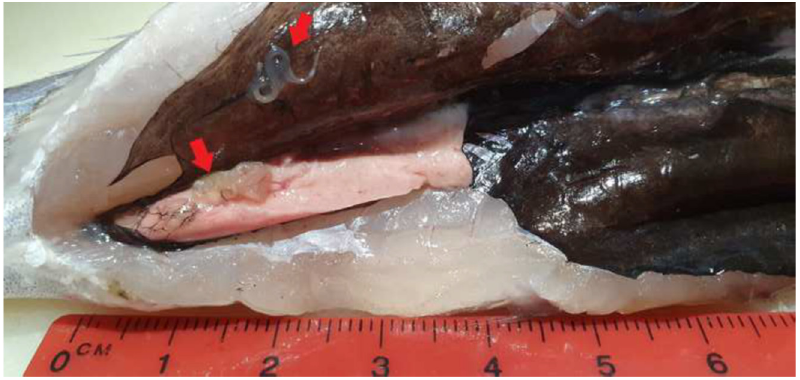
Figure 2. Visceral remains with ascaridoid larvae in a blue whiting gutted at the supermarket. In this category, the prevalence of ascaridoid larvae was 25% ( n = 30). Four of the specimens presented massive infection, with mean abundance in the muscle for the other 26 infected being 5.0 ± 1.1. In the under-24-h subgroup, prevalence was 23.3%, with 79.2% of the infected fish presenting larvae in the muscle. Of the over-24-h subgroup, 35.2% of the fish were infected, with 100% of them showing larvae in the muscle ( n = 6). In both gutted and ungutted fish, prevalence in the muscle for the under-24-h subgroup was lower, but these differences were only statistically significant for the ungutted category (Table 1). Both in the under-24-h and in the over-24-h subgroups, infection in muscle was similar in ungutted and gutted groups (21 vs. 18.4, and 40.7 vs. 35.3, respectively). The total prevalence of ascaridoid larvae in ungutted fish was higher than in gutted, both in the over-24-h and in the under-24-h (52.9 vs. 23.3, and 65.4 vs. 35.3, respectively) (Table 1) ( p <